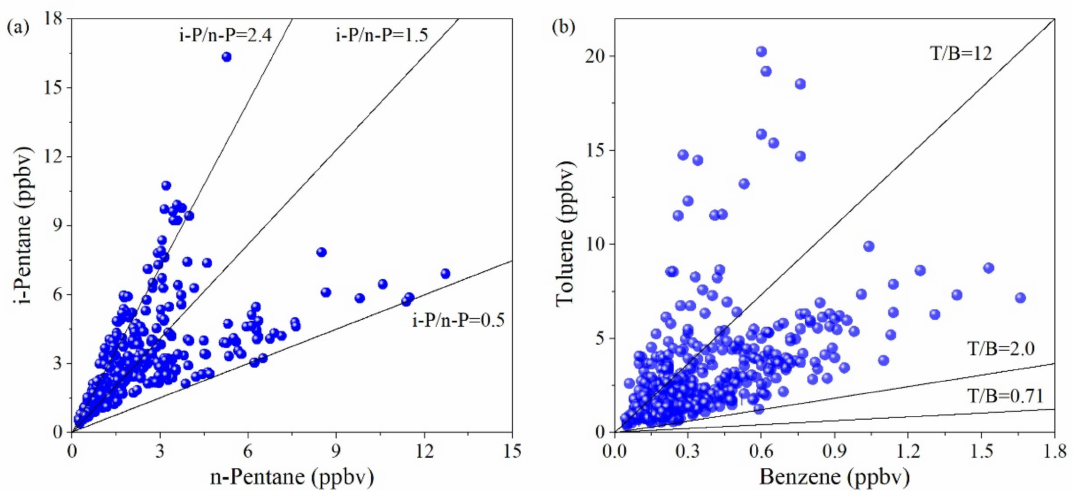
Figure 6. Ratios of ( a ) i-pentane/n-pentane and ( b ) toluene/benzene at PY site during